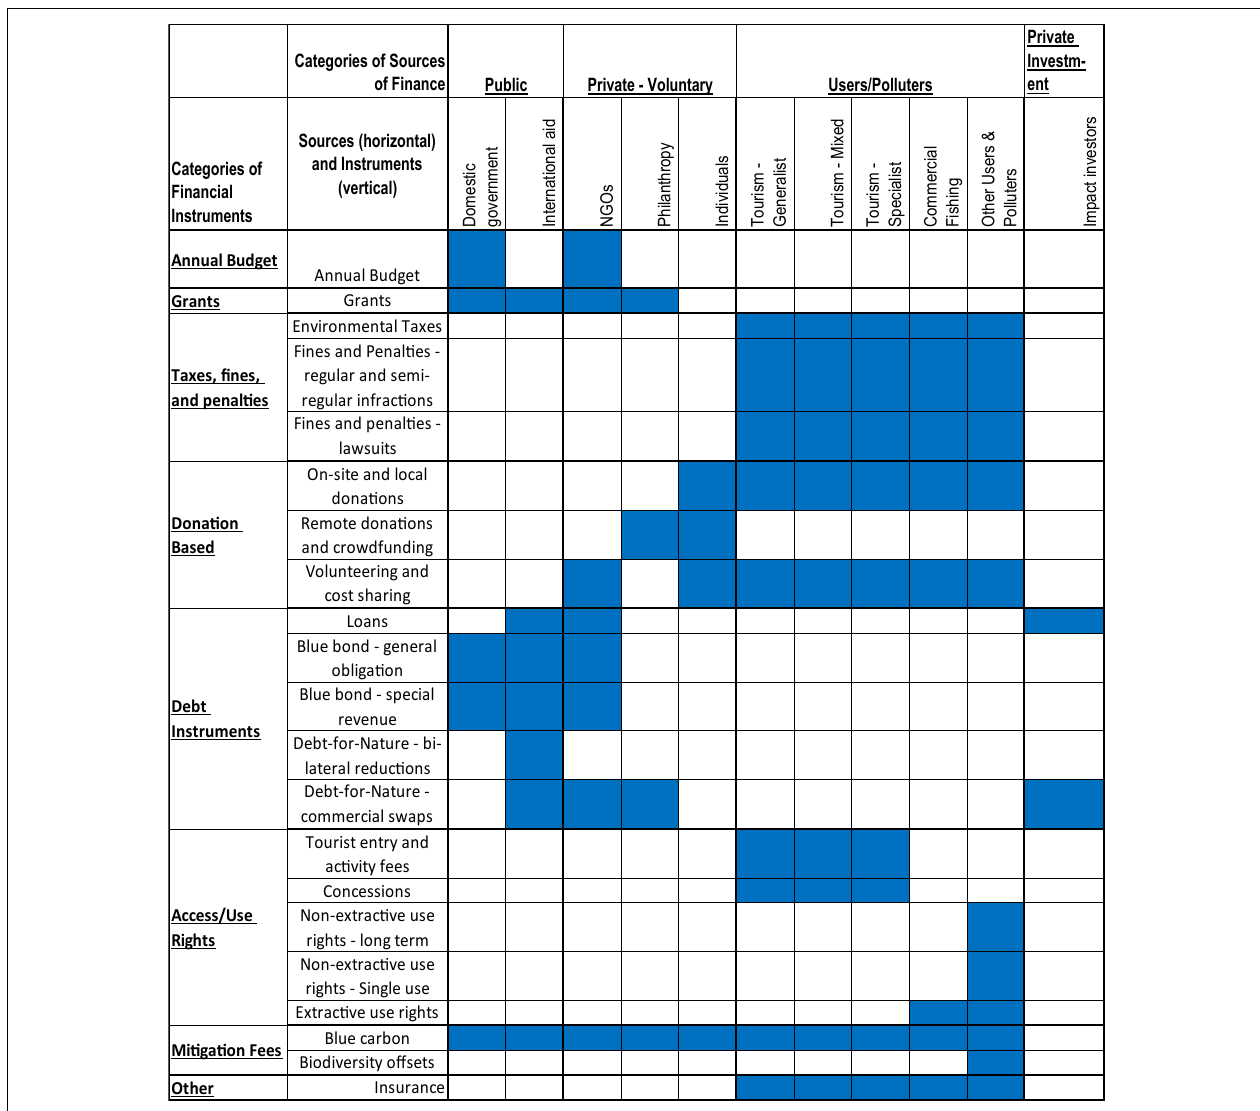
FIGURE 6 | Matrix of potential interactions between sources of finance and financial instruments, blue cells indicate potential pairings.